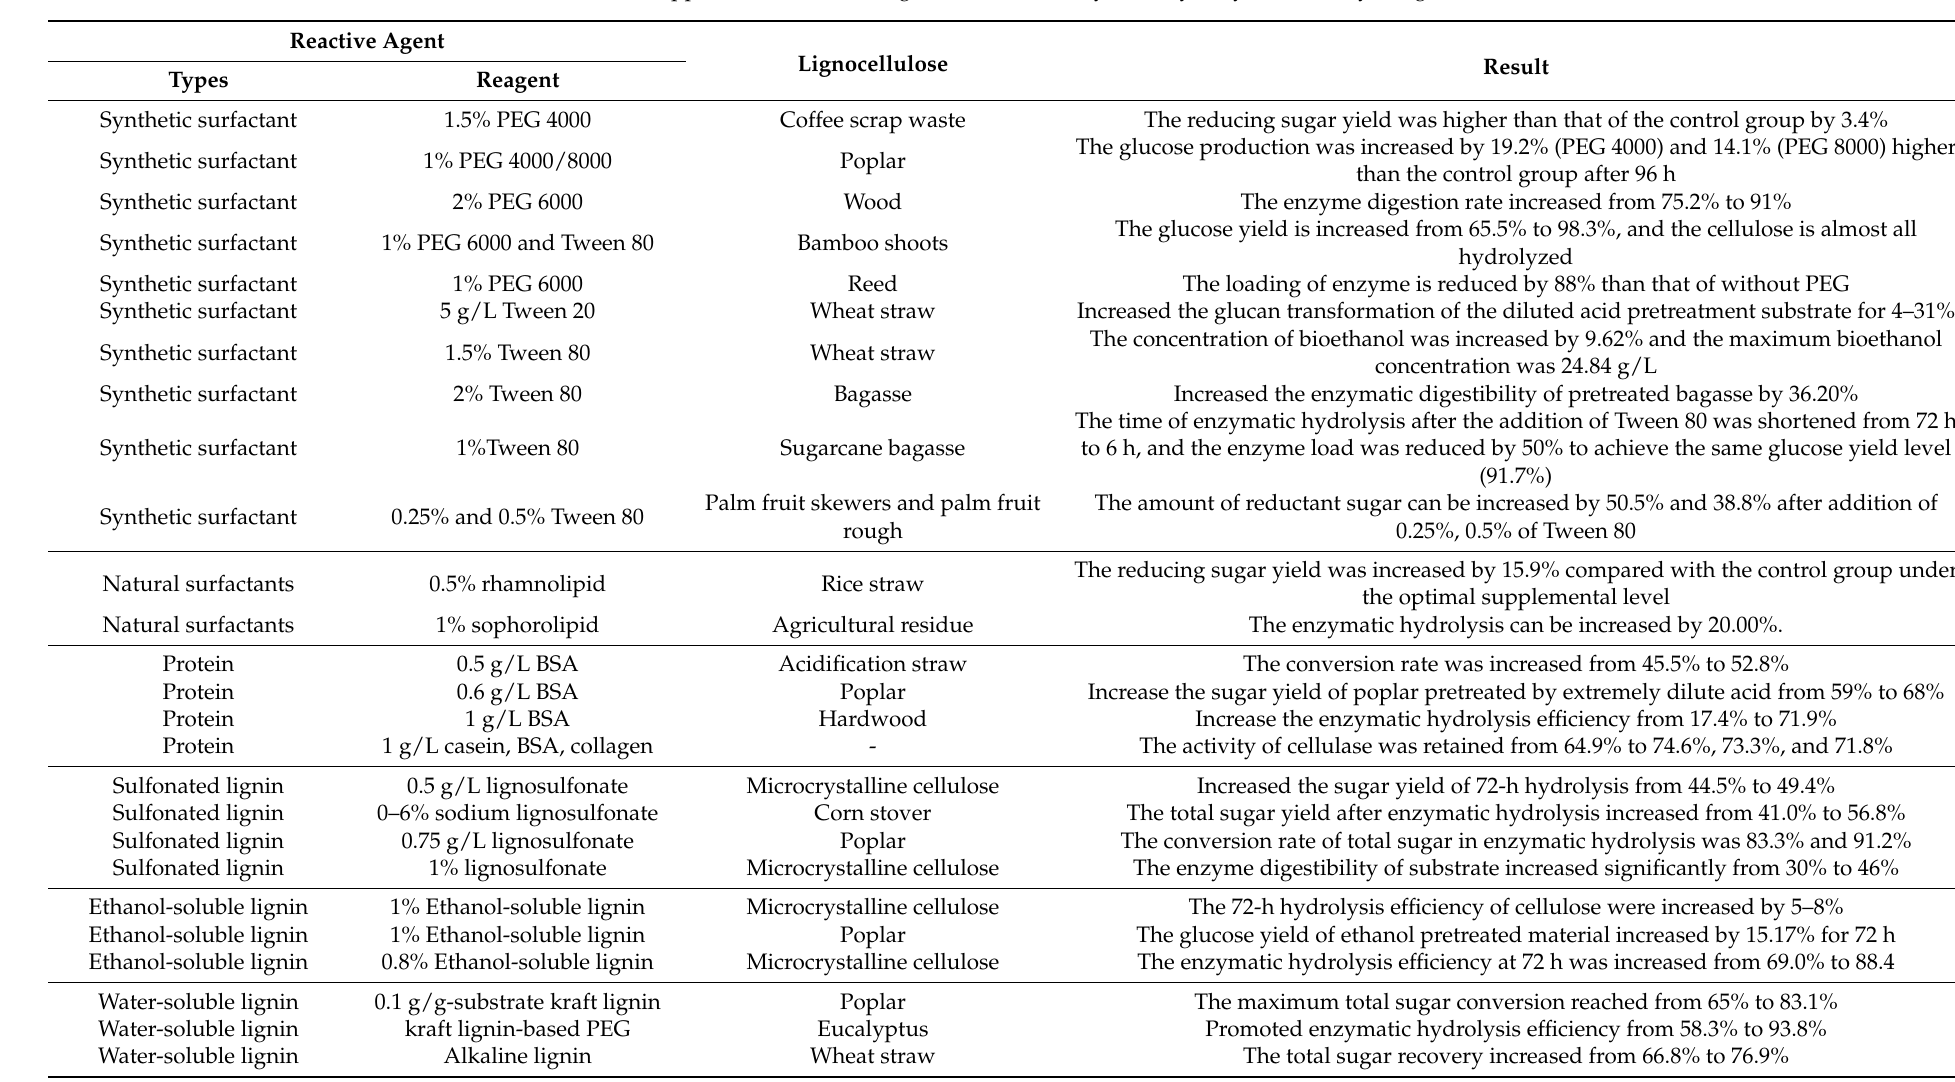
Table 2. The over reviews of application of reaction agent to increase enzymatic hydrolysis efficiency of